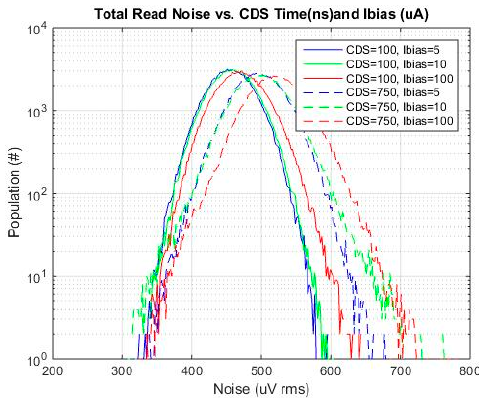
Figure 13. Total read noise histogram for selected CDS times and SF Ibias.